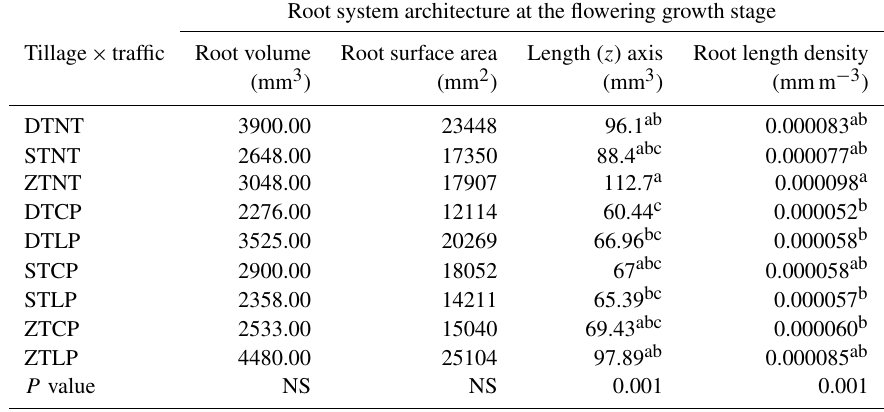
Table 6. Root system architecture analysis using a non-destructive method.